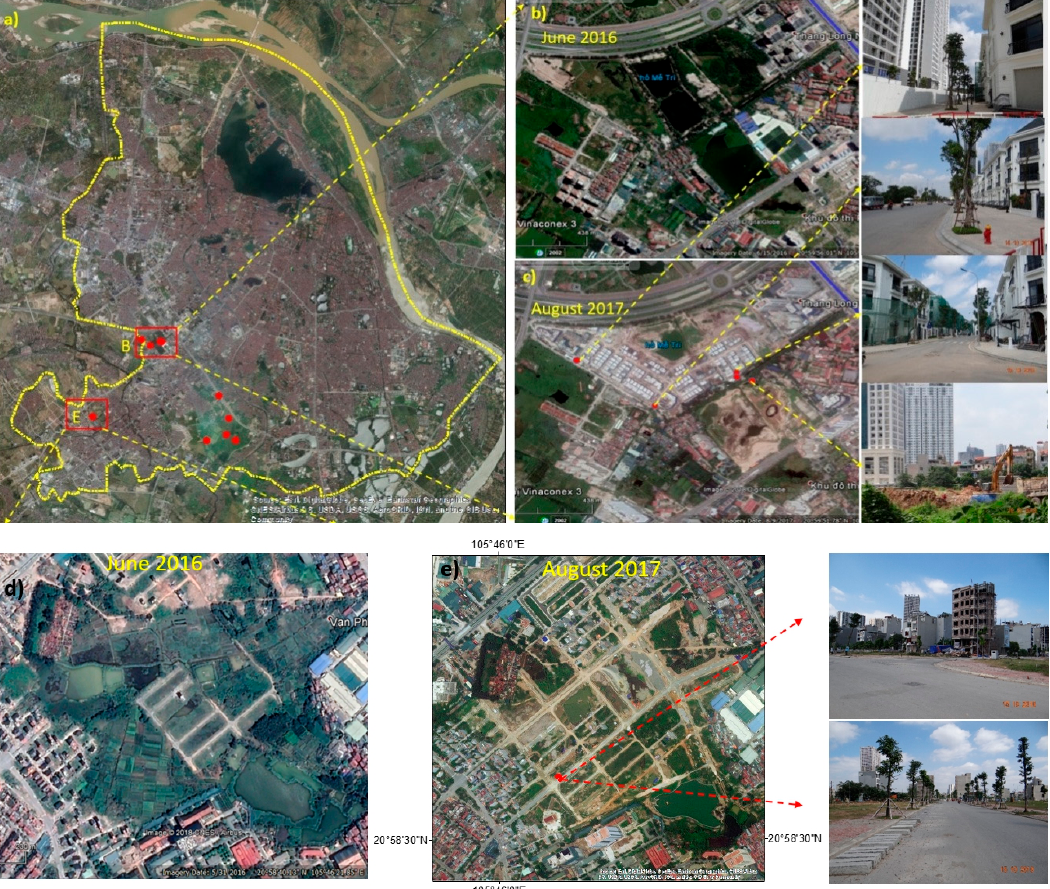
Figure 4. Land-use maps of inner Hanoi city for ( a ) 1 June 2016, and ( b ) 4 June 2017. Areas with substantial land-use changes are visually chosen and labeled as A, B, C, E, and F in ( c ) and ( d ) with coverage percentage statistics for the three major land-use types of concern and others in the years 2016 and 2017, respectively.